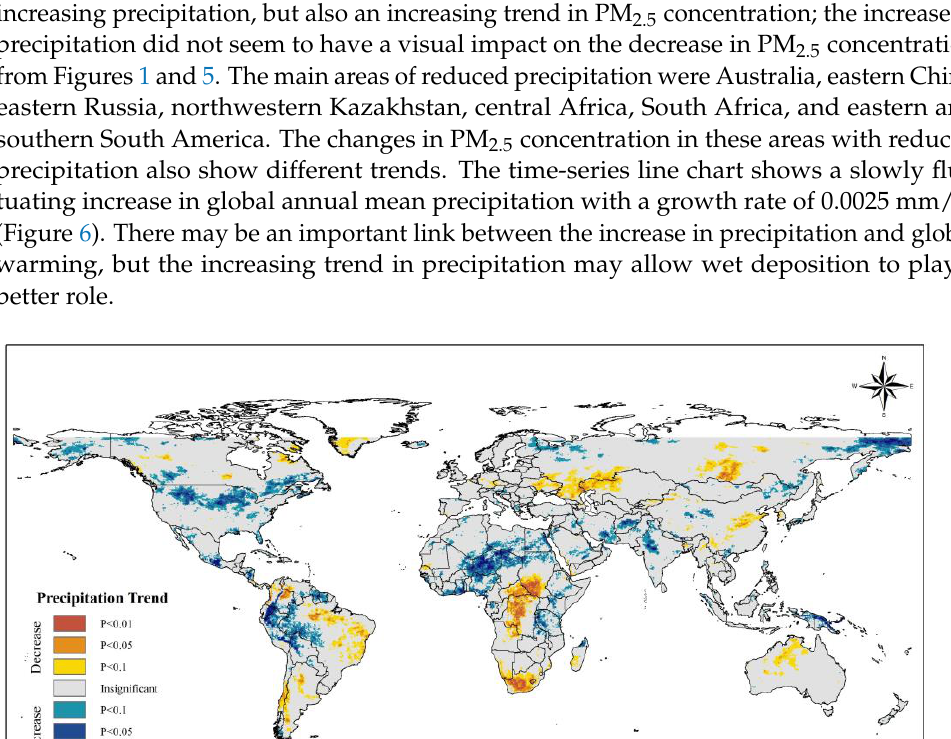
Figure 6. Time series of annual mean precipitation from 2000 to 2019. Global warming is becoming an increasingly prominent issue, and has significant implications for the Earth ’ s natural environment. The generation of the greenhouse effect has led to changes in the characteristics of meteorological factors, resulting in changes in natural conditions such as regional precipitation and temperature, and it also has had an